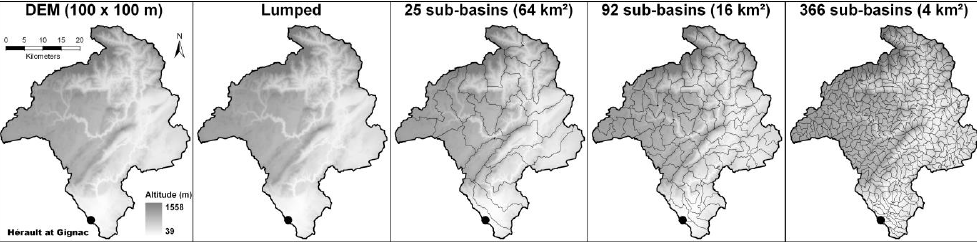
Fig. 4. Examples of lumped and semidistributed catchment discretizations (with unit sizes of 64, 16 and 4km 2 ) for the Hérault catchment at Gignac (1430km 2 ). Figure 4. Example of lumped and semi-distributed catchment discretizations (with unit sizes 3 of 64, 16 and 4 km²) for the Hérault catchment at Gignac (1430 km²). 4